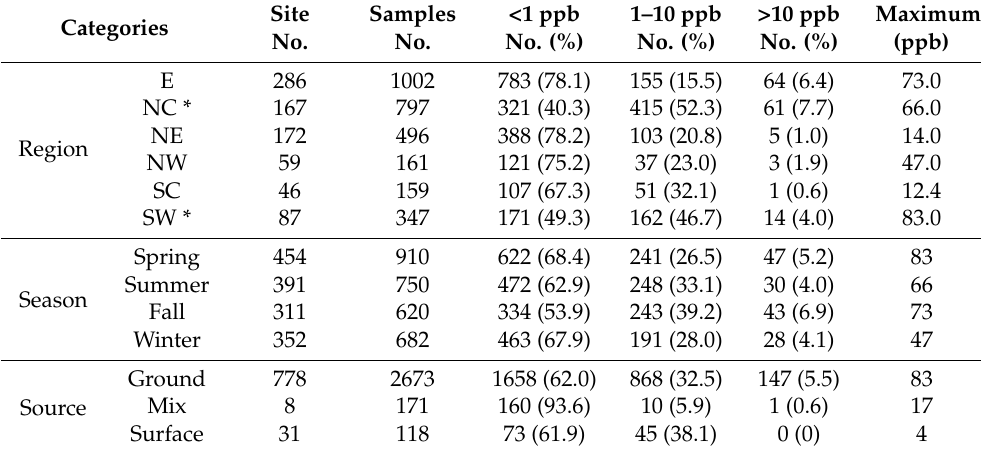
Table 1. Occurrence of Arsenic in Public Water Systems (Drinking Water MCL = 10 ppb).